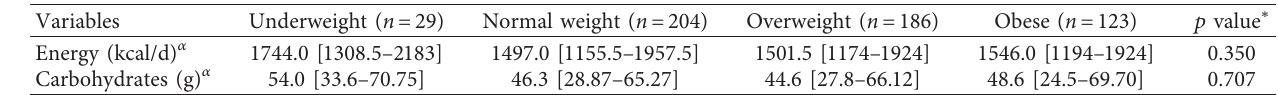
Table 5: Association of energy and macronutrients intakes with nutritional status.